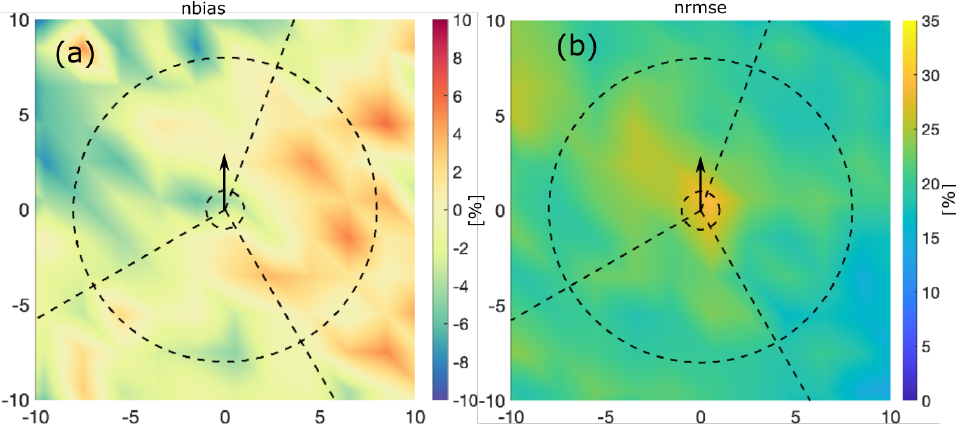
Figure 12. As in Figure 3 for relative nbias ( a ) and nrmse ( b